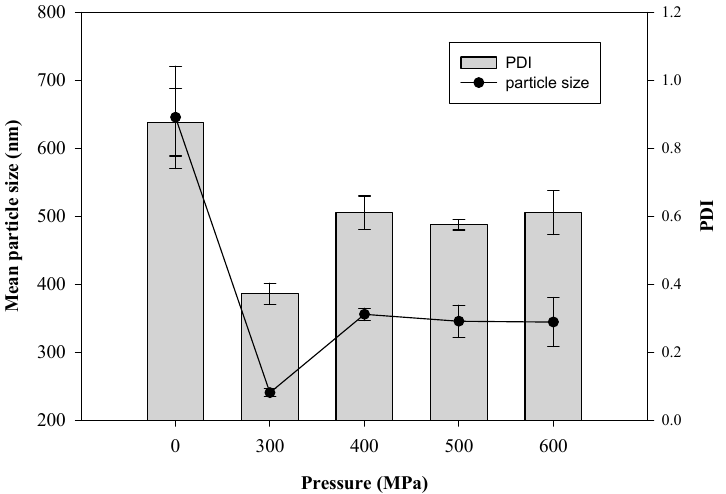
Figure 3. Effect of pressure on mean diameter and polydispersity index (PDI) of CTP liposomes prepared by the HPP method.